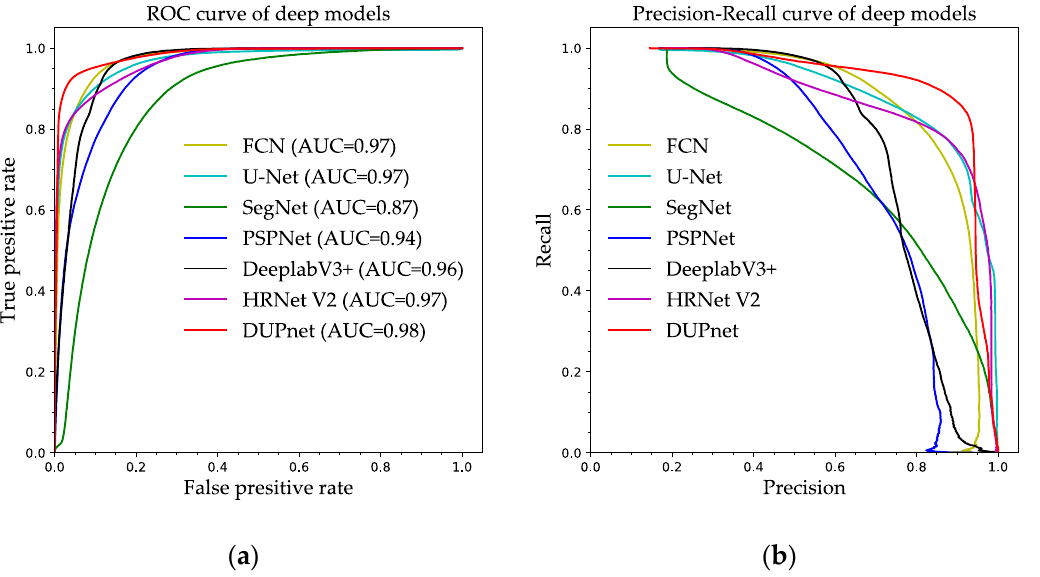
Figure 11. ROC and P–R curves for evaluating the ability of different models to segment water on the LR dataset. ( a ) ROC curves for evaluating different models on water body segmentation, ( b ) P-R curves for evaluating different models on water body segmentation.